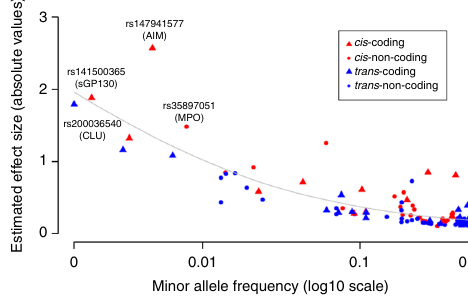
Fig. 3 pQTL variant minor allele frequency vs. effect size. Minor allele frequency of sentinel pQTL variants ( X -axis) vs. effect size of variants on proteins. The average absolute estimated effect size (per standard deviation per allele) is signi fi cantly different (by the unequal variance t - test) between coding and non-coding pQTL variants (0.56 versus 0.31, P = 0.02), and also signi fi cantly different between cis and trans -pQTL variants (0.53 vs. 0.30, P = 0.017). pQTL protein quantitative trait previously reported in GWAS. We attempted to replicate all 103 sentinel pQTL variants in the INTERVAL 15 ( N = 3301) and